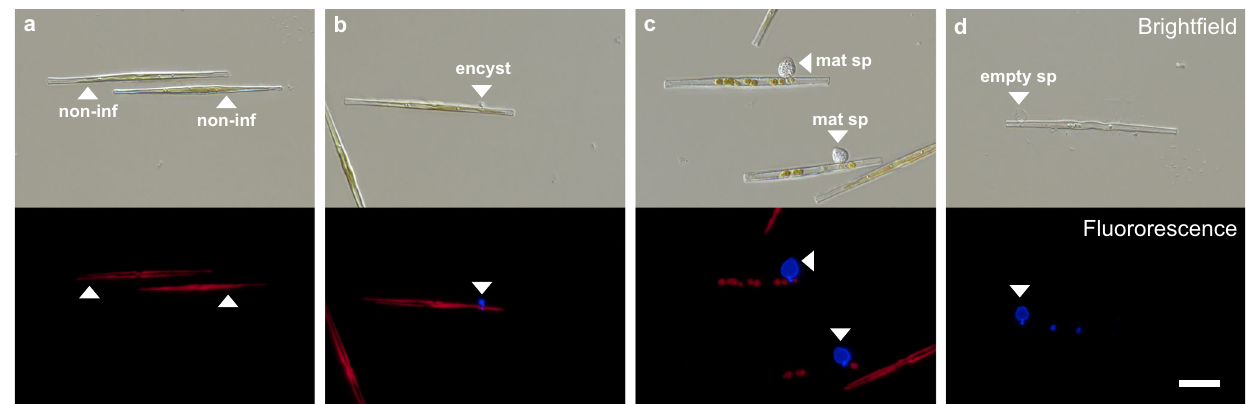
Fig. 1 Micrographs of the diatom host ( Synedra ) and fungal microparasite (chytrid Zygophlyctis ) at different infection stages. a Non-infected (non-inf) healthy diatom cells. b Infected diatom with encysted zoospore (encyst, early-infected), which developed into a c mature sporangium (mat sp, maturely- infected) with new zoospores inside. The zoospores are eventually discharged into the ambient water, leaving behind an empty transparent sporangium (empty sp, post-infected) on a non-viable host cell ( d ). Shown are bright fi eld and epi fl uorescence (Fluorescence) images. Sporangia are displayed in blue (stained with Calco fl uor White) and diatom chloroplasts in red (chlorophyll auto fl uorescence). Scale bar is 20 µ m (applies to all panels).